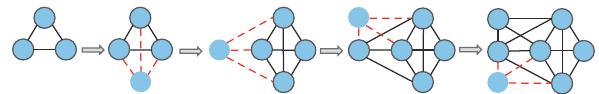
Figure 2: Evolution process when the number of initial nodes is